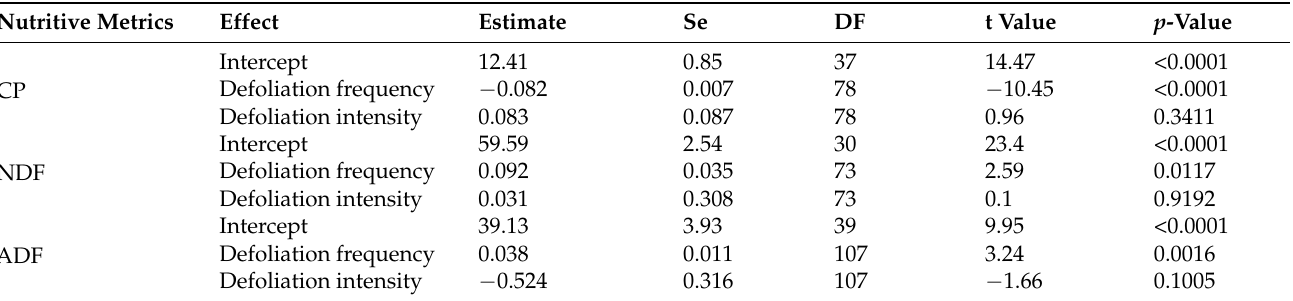
Table 4. Effect of defoliation frequency and defoliation intensity on nutritive values of tropical pasture species estimated from the linear mixed-effects